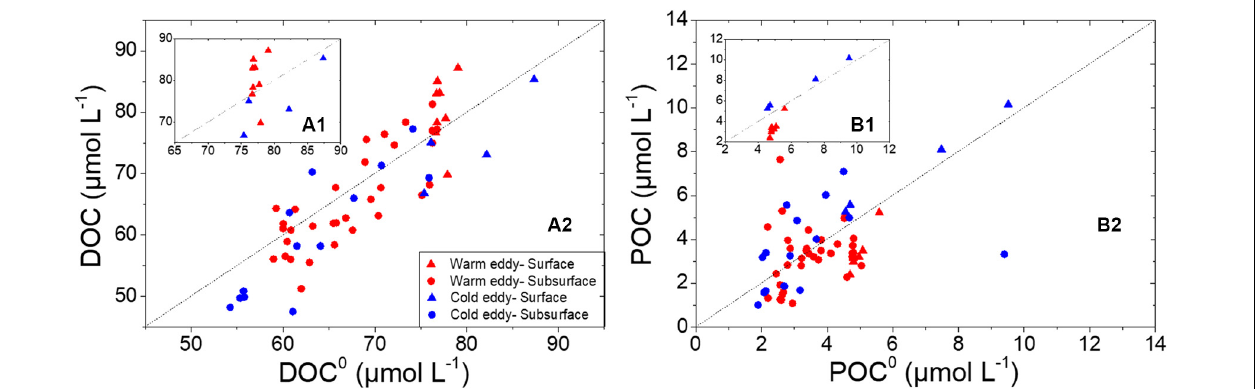
FIGURE 6 | Measured DOC vs. modeled DOC 0 (A) and measured POC vs. modeled POC 0 (B) derived from the mixing model. Triangles represent samples of surface, while circles represent subsurface samples. Marks in red represent samples in warm eddy and in blue represent samples influenced by cold eddy. The gray dashed line means that the modeled value was equal to measured